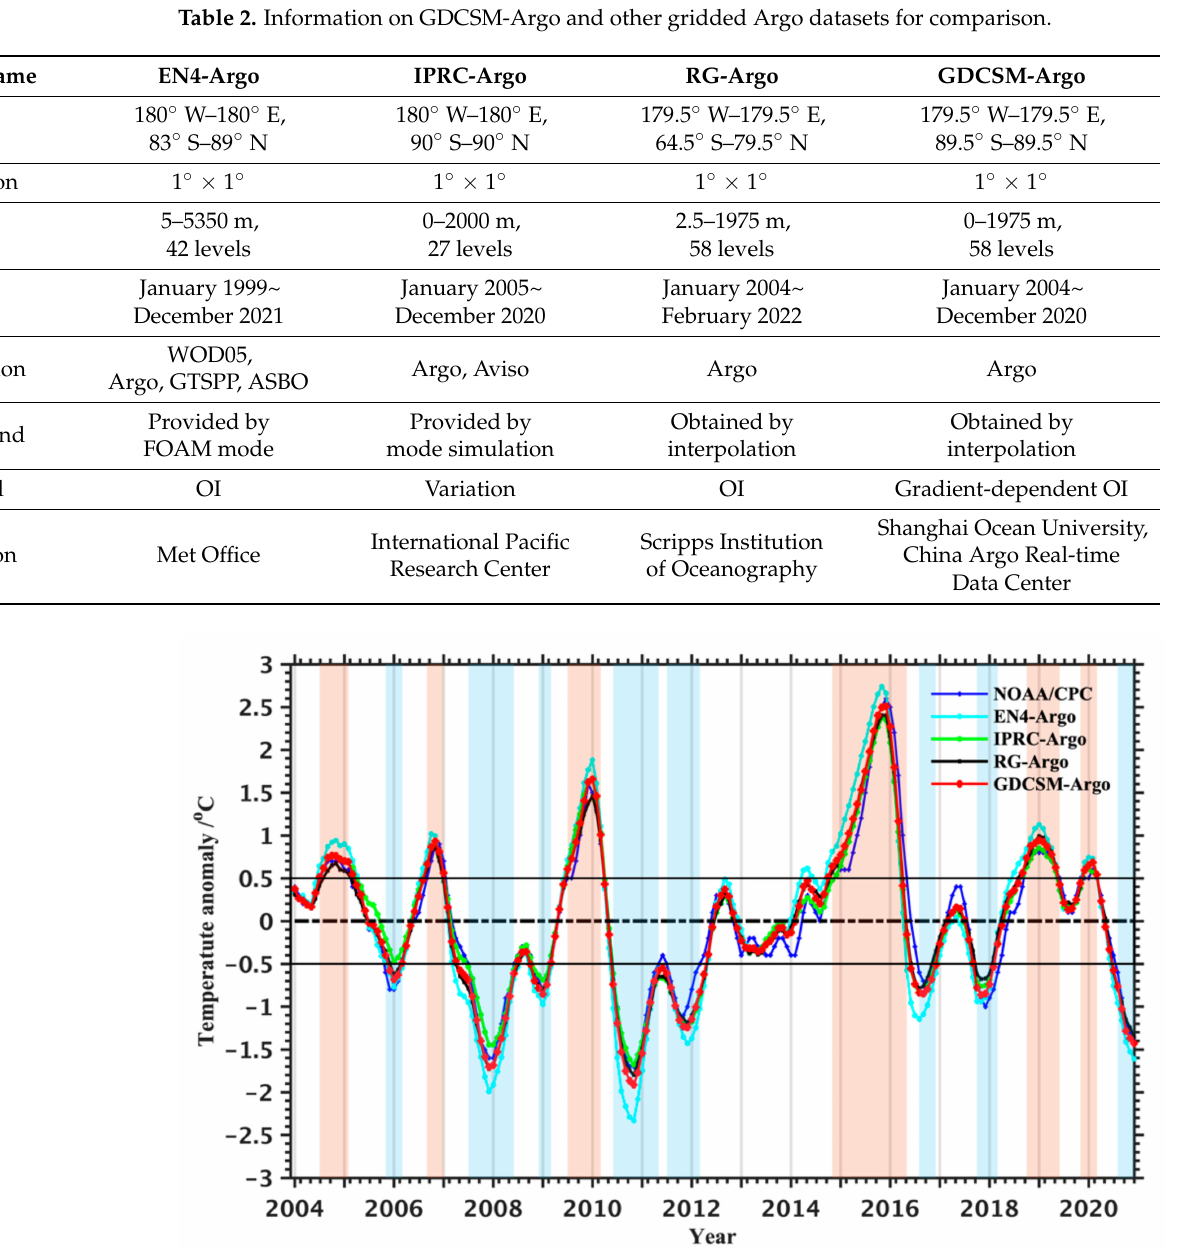
Figure 7. Time series of temperature anomalies in the Nino3.4 region (170 ◦ W–120 ◦ W, 5 ◦ S–5 ◦ N), based on data from the uppermost 100 m of the ocean, from multiple gridded oceanographic datasets. The anomalies were calculated relative to the annual climatology from the corresponding gridded dataset. The red rectangles indicate El Nino events and the blue rectangles show La Nina